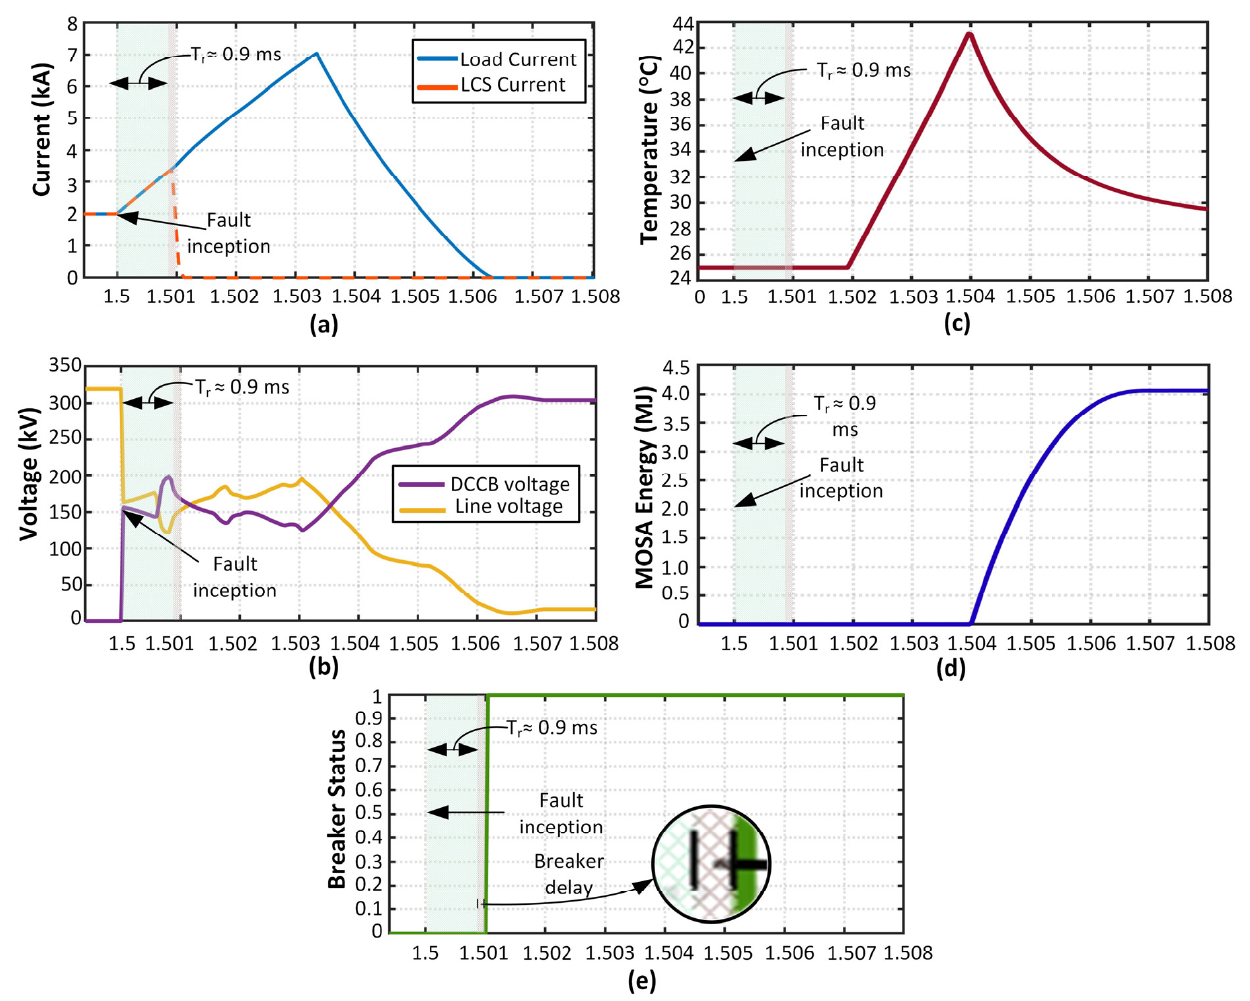
Figure 13. Fault current interruption under 0.8 ms time window ( a ) DC fault current, ( b ) Line and DCCB voltage, ( c ) IGBT valve temperature, ( d ) MOSA energy absorption , ( e ) Breaker Status.